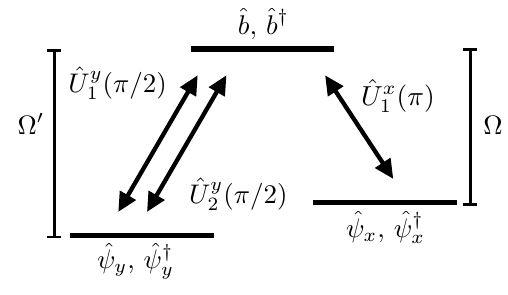
Figure 3: Schematics of the measurement scheme. We construct an effective Λ - type level scheme and propose to introduce rotations between the states with Raman transitions or microwave coupling with strengths Ω , Ω ′